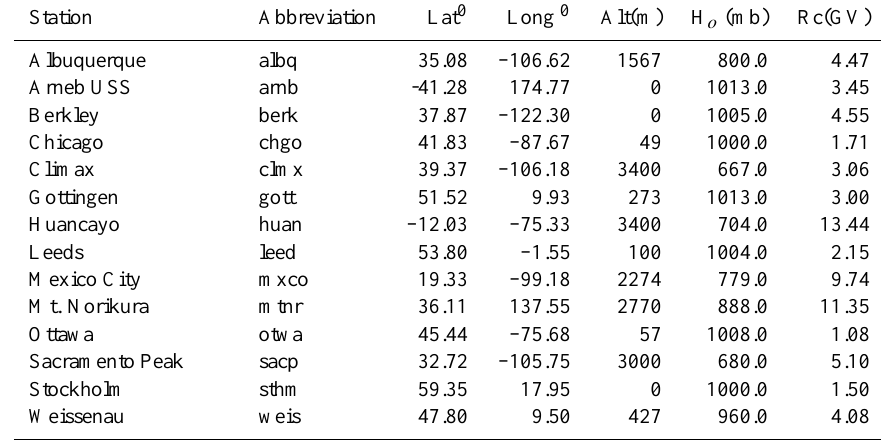
Table 1. Neutron monitor stations which data are employed in this analysis.